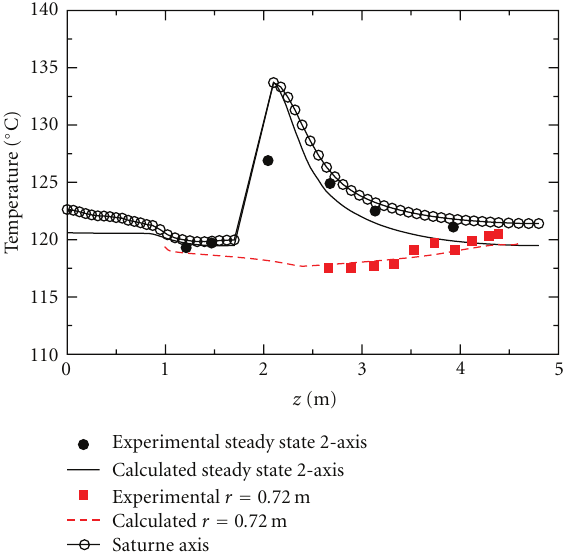
Figure 11: Vertical profile of the gas temperature along the axis and r = 0 . 72 m (near the wall): steady state 2.